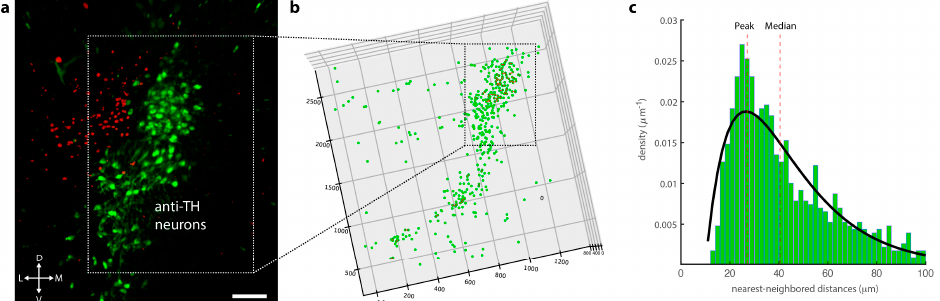
Figure 2. The largest fraction of noradrenergic neurons have neighboring LC neurons at a distance of 25 µ m. ( a ) A typical fluorescent volume from a 2-mm cleared brain stem slice. Expression of red dtomato fluorescent is driven from a Dlx5/6-Cre mouse line. While green depicted neurons are anti- TH/CY3 immunopositive neurons (scale bar 100 µ m). ( b ) Cell segmentation was manually performed with IMARIS software and validated through two observers. The mean number of recovered LC neurons was 289 ± 45 ( n = 4, 2 animals). Anti-TH positive neuron had a mean sphericity of 0.83 ± 0.12 and a mean volume of 4971 ± 0.233 µ m 3 . ( c ) Nearest-neighbor distance histogram of pooled data sets from all four LC nuclei. Distances between neurons with less than 25 µ m are connected through a red line. Nearest-neighbor distribution was fitted to a double exponential function ( γ = 1.38, λ long = 16.84 and λ short = 16.23). The model predicts that the highest number of neurons are in bins between 24 and 28 µ m. The peak of NN distribution and median are marked as dotted